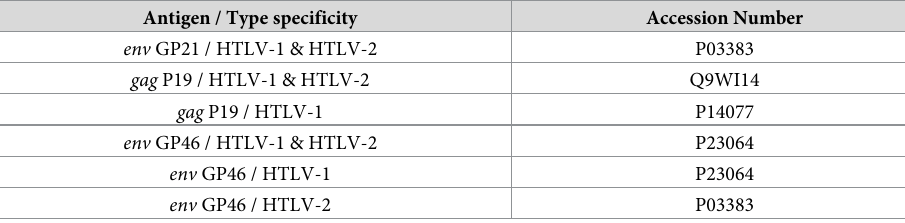
Table 2. Antigen’s description.